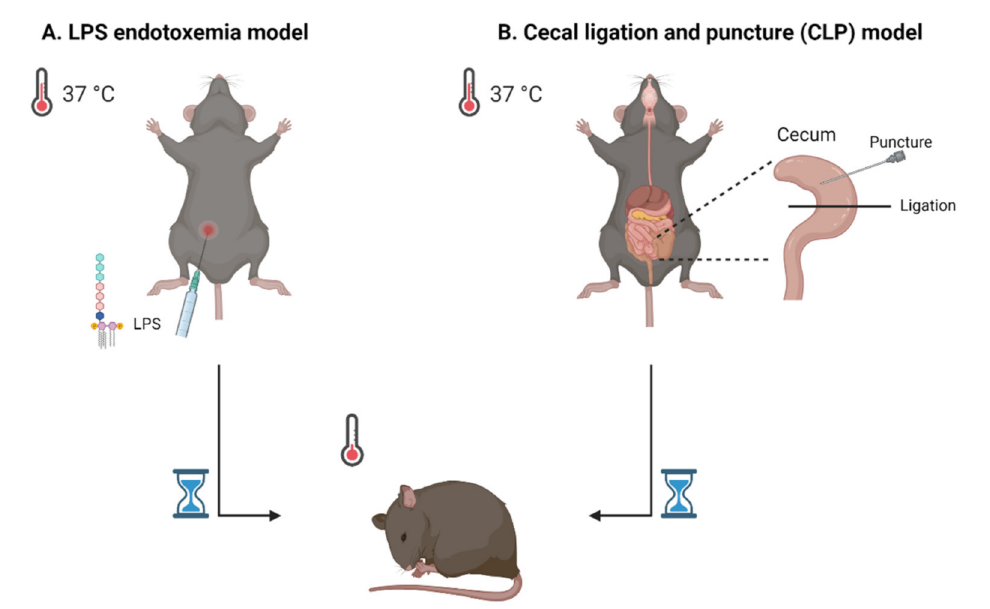
Figure 1. Schematic representation of two frequently used sepsis models. ( A ) The lipopolysac- charide (LPS) endotoxemia model implies injection (mostly intraperitoneally) of the PRR agent LPS. ( B ) The cecal ligation and puncture (CLP) model is established by puncturing and ligating the cecum, by which feces can enter the peritoneal cavity. In both models, one of the disease symptoms is hypothermia, which can be monitored by measuring body temperature. Figure created with